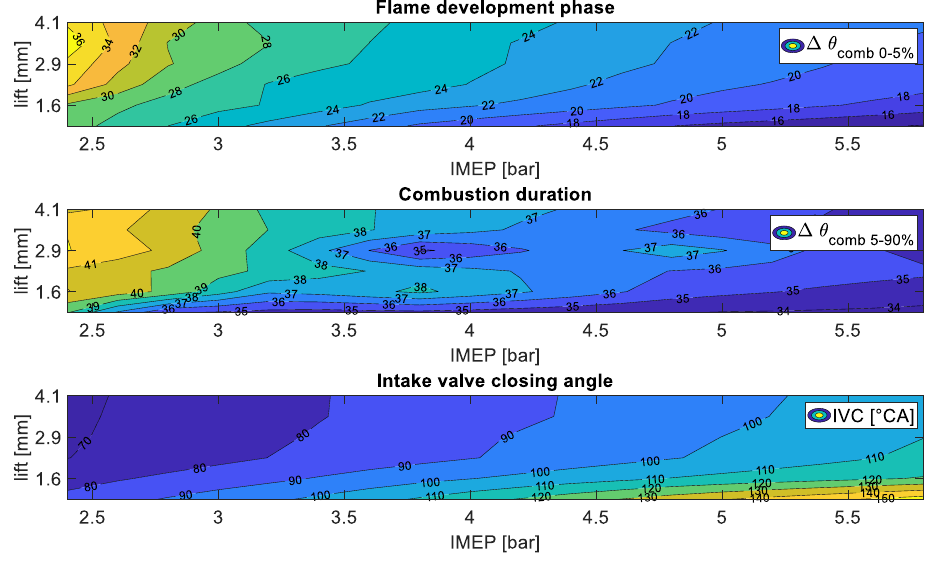
Figure 5. Combustion duration and IVC angle.